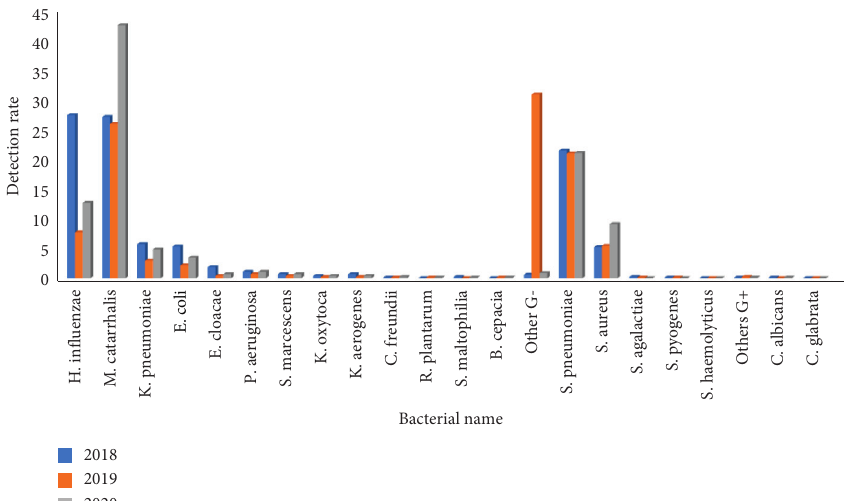
Figure 10: Detection rate of pathogens in lower respiratory tract in the fourth quarter before and after the pandemic situation of COVID-19 (%).